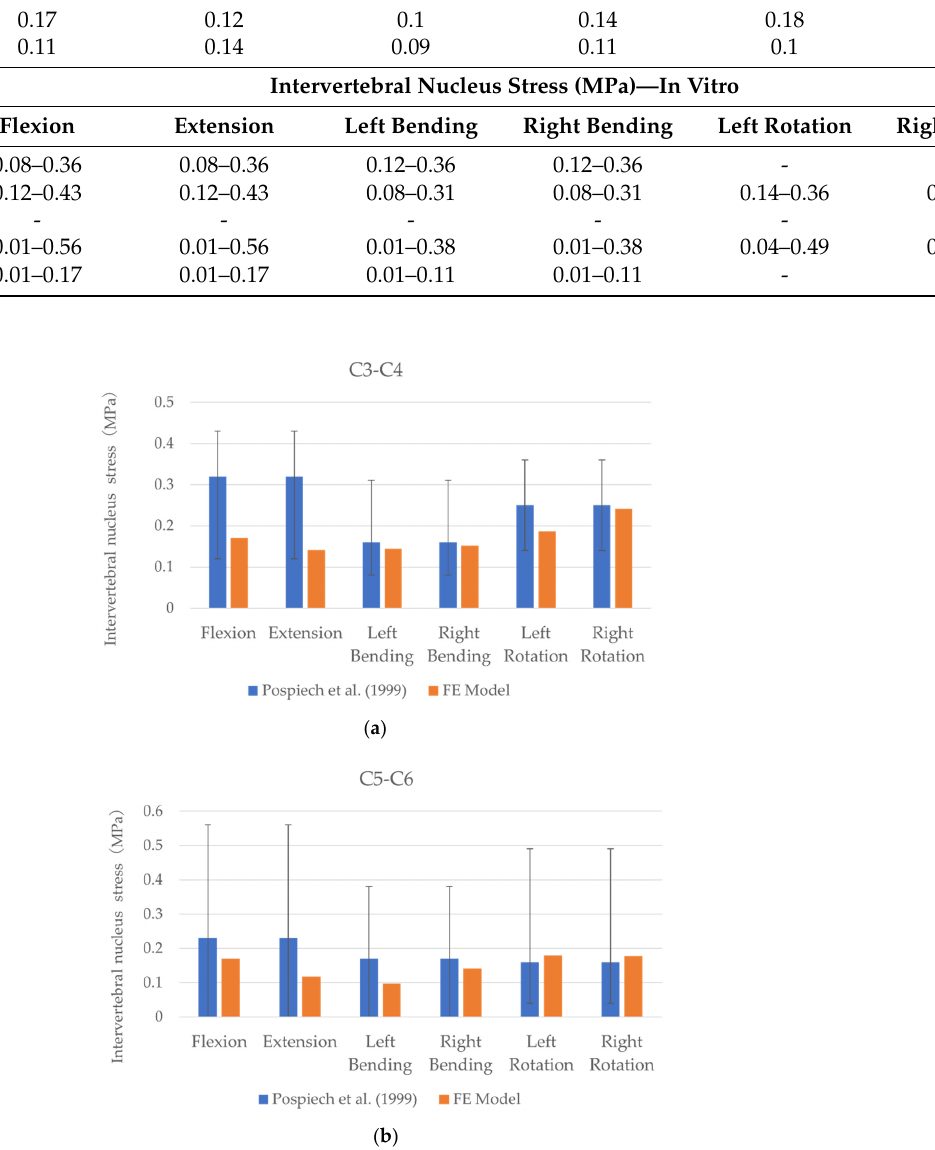
Figure 4. ( a ) Comparison of the intervertebral nucleus stress at C3–C4 between the FE model results and the results reported in the literature [24] . ( b ) Comparison of the intervertebral nucleus stress at C5-C6 between the FE model results and the results reported in the literature